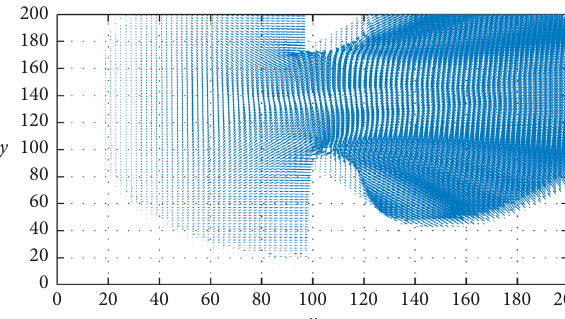
Figure 11: Velocity field of partial dam-break problem at 7.2s, wet/dry case.